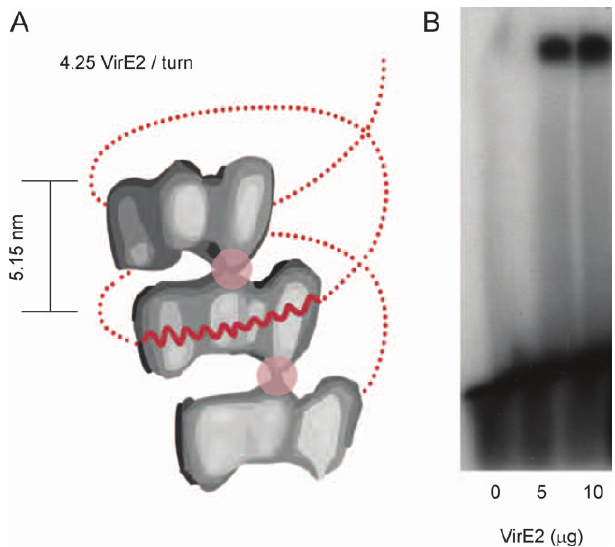
Figure 2. Local Binding Mode of VirE2 on ssDNA and Helical Structure of VirE2-ssDNA Filament (A) Schematic representation of the VirE2-ssDNA helical structure (adapted from [18]). Only three individual VirE2 monomers are shown. The approximate location of the ssDNA helix is shown in red (dots). The overall VirE2-ssDNA structure is stiffened up by strong axial interactions between the VirE2 proteins (pink circles). The binding of VirE2 monomers to ssDNA is such that the distance between adjacent ssDNA-phosphates of the backbone is 0.41 nm projected along the long axis of the protein (thick red line). (B) The formation of nucleoprotein complex between VirE2 and 5 pmoles of a 12-mer oligonucleotide was analyzed by radioactive gel shift assay. Lane 1: 12-mer without VirE2. Lanes 2 and 3: 12-mer with, respectively, 5 l g and 10 l g of VirE2. Upon interaction of VirE2 with the 12-mer, a higher-mass complex can be detected in the upper part of the gel (lanes 2 and 3). This indicates the binding of VirE2 to the 12-mer. The addition of double the amount of VirE2 leads to the formation of double the amount of complex (lane 3), showing that the formation of the higher mass complex is VirE2 dependent.